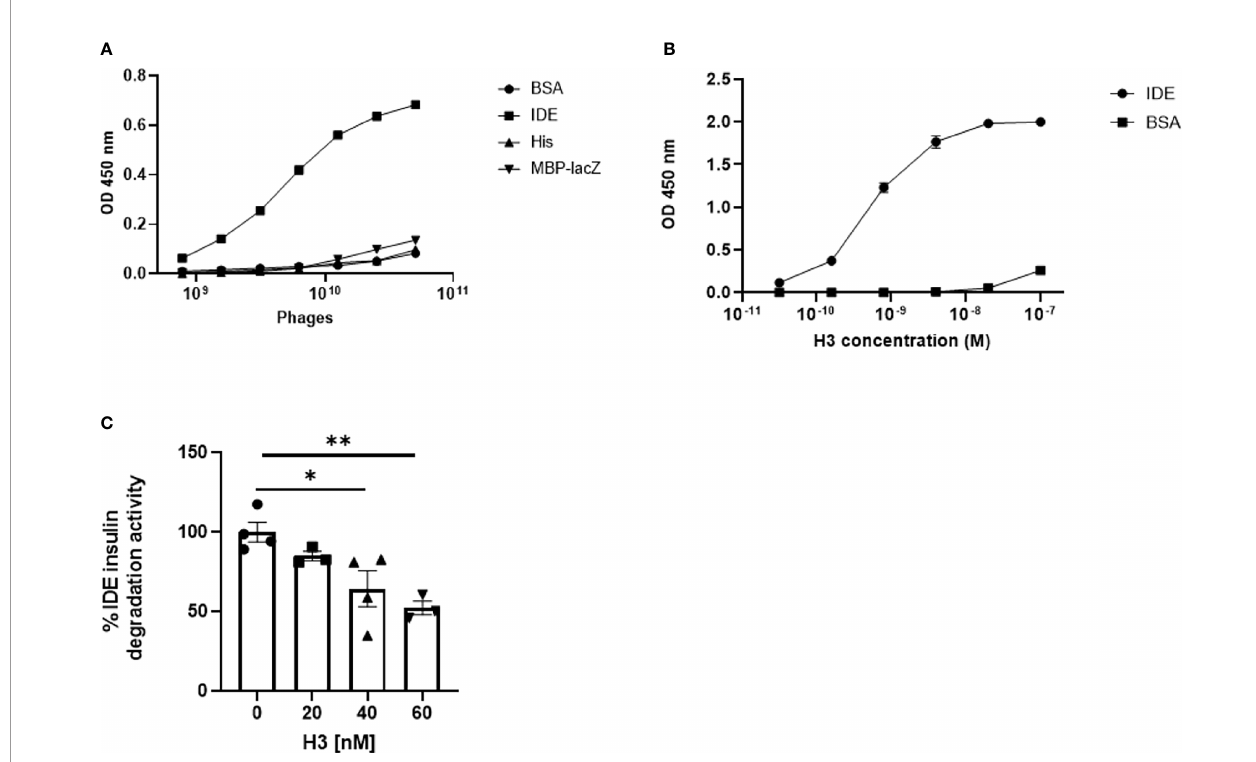
FIGURE 2 | Binding of IDE by IDE-speci fi c phage displayed antibodies and binding and inhibition of IDE by “ Inclonal ” human IgGs. (A) Analysis of IDE binding by H3 scFv displaying phages in ELISA. The analyzed scFv displaying phages were added in serial dilutions to ELISA plate wells previously coated with 2.5 µg/ml of rhIDE WT (IDE) and non-relevant proteins: BSA, a His trap-puri fi ed protein (His) and MBP-LacZ. Bound phages were detected with mouse anti-M13 antibody followed by HRP-conjugated goat anti-mouse secondary antibody. The results are presented as mean ± SEM (n = 3). (B) Analysis of IDE binding by puri fi ed “ Inclonal ” human IgG in ELISA. The analyzed antibodies were added in serial dilutions to ELISA plate wells coated with 2 µg/ml of IDE WT and BSA. Bound antibodies were detected with a HRP-conjugated goat anti- human secondary antibody. The results are presented as mean ± SEM (n = 4). (C) Evaluation of inhibition of IDE-mediated cleavage of insulin by human H3 IgG by ELISA. IDE (1.2 µg/ml) was incubated with 20, 40, or 60 nM of the antibodies 1/2 h at 25°C, followed by incubation of 1.5 µg/L of human insulin 1 h at 37°C. Residual insulin was later analyzed using Mercodia ultrasensitive mouse insulin ELISA kit. The results are presented as mean ± SEM (n = 3 – 4). *p < 0.02. *p = 0.0227, **p =